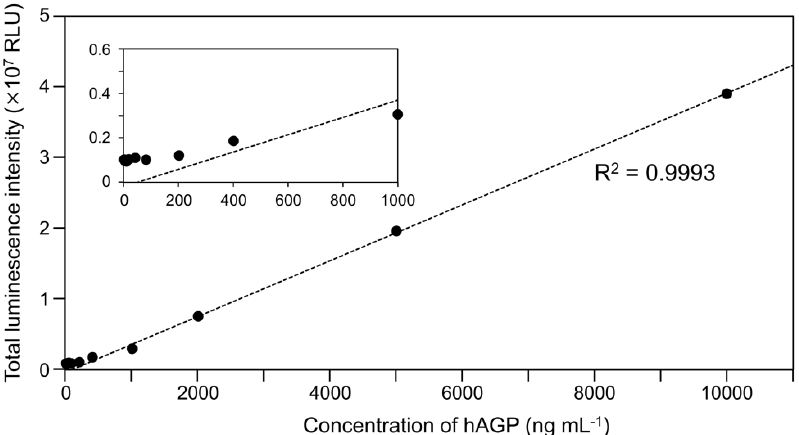
Figure A3. Luminescence intensity of Cypridina luciferin with various concentrations of hAGP under a Gly-NaOH (pH 9.5) buffer condition: quantitative linearity (correlation efficient R 2 = 0.9993) was observed from 400 ng mL −1 to 10 mg mL −1 . The bars represent the mean values ± SD for n = 3. The inset shows an enlarged view of the range from 0–1000 ng mL −1 .